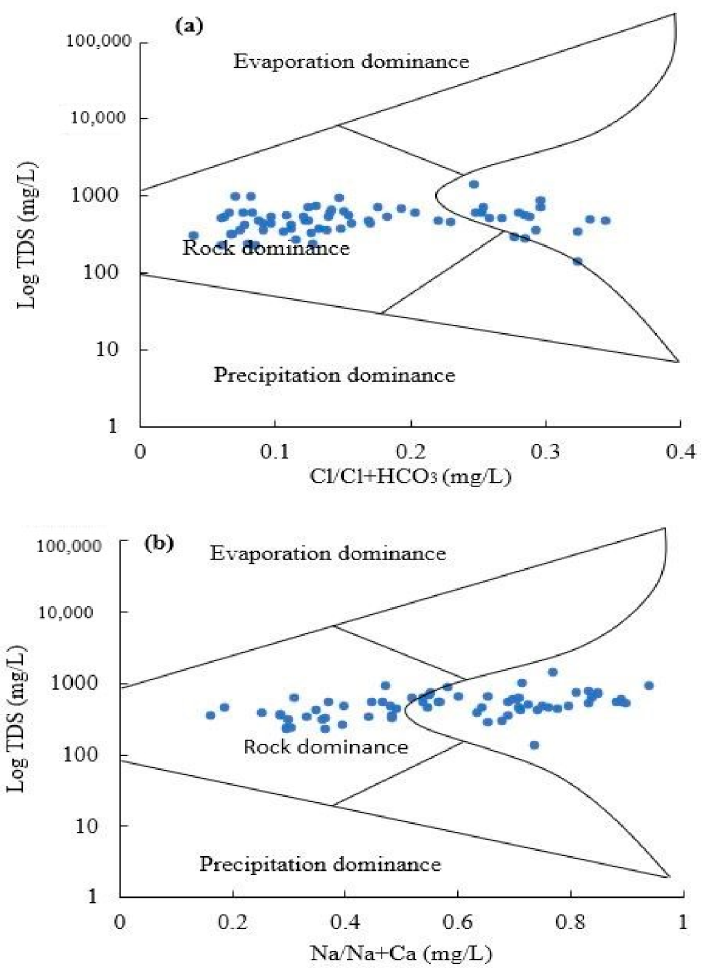
Figure 5. The Gibbs diagram demonstrates the ionic composition of the samples of groundwater. ( a ) Cl/Cl + HCO 3 mg/L versus Log TDS. ( b ) Na/Na + Ca mg/L versus Log